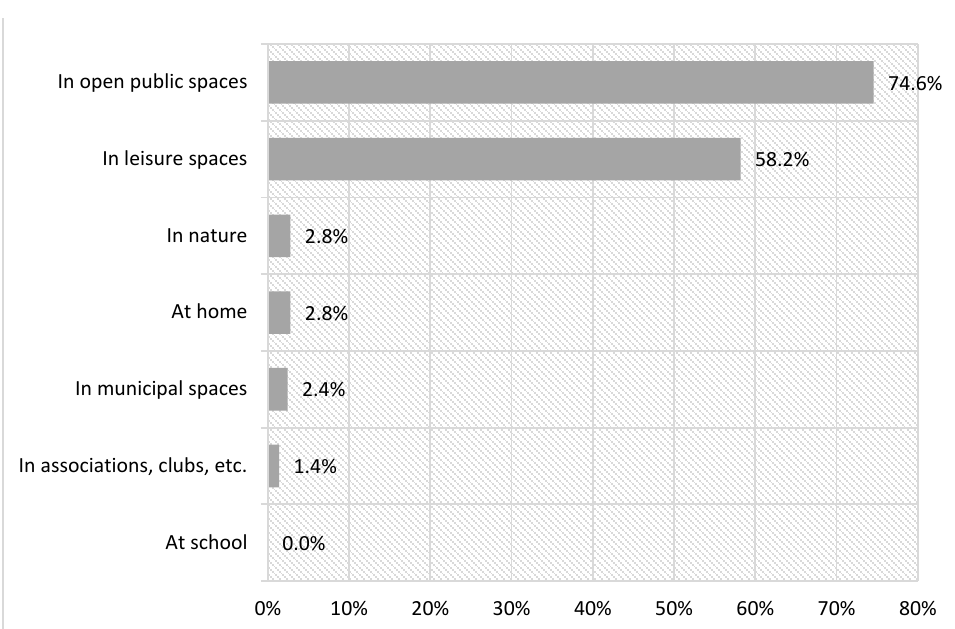
8 of 15 Figure 5. Frequency of shared festive leisure activities.